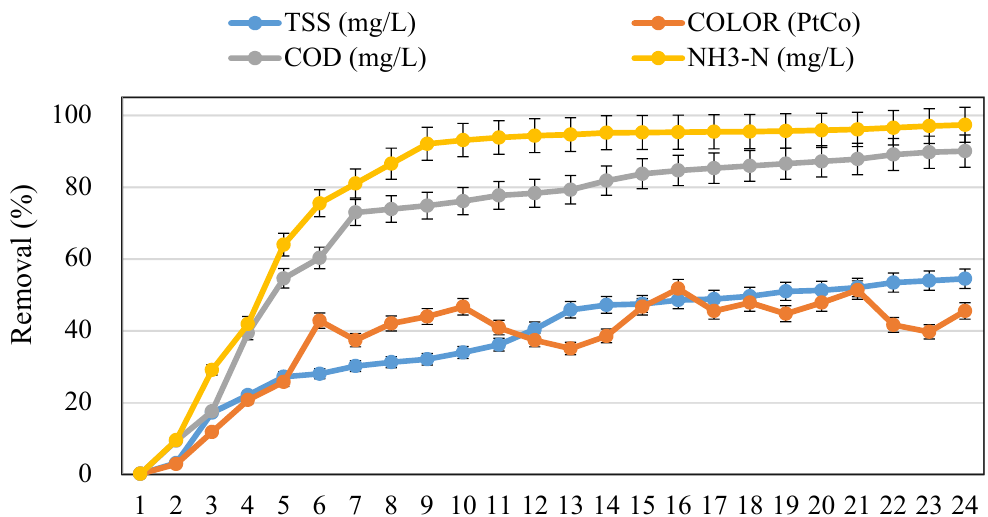
Figure 3. E ff ects of reaction time variation on COD, TSS, color, and NH 3 -N removal e ffi ciency Figure 3. Effects of reaction time variation on COD, TSS, color, and NH 3 -N removal efficiency (with (with natural pH, leachate / POME (700 mL leachate / 300 mL POME), aeration power 20L / natural pH, leachate/POME (700 mL leachate/300 mL POME), aeration power 20L/min).